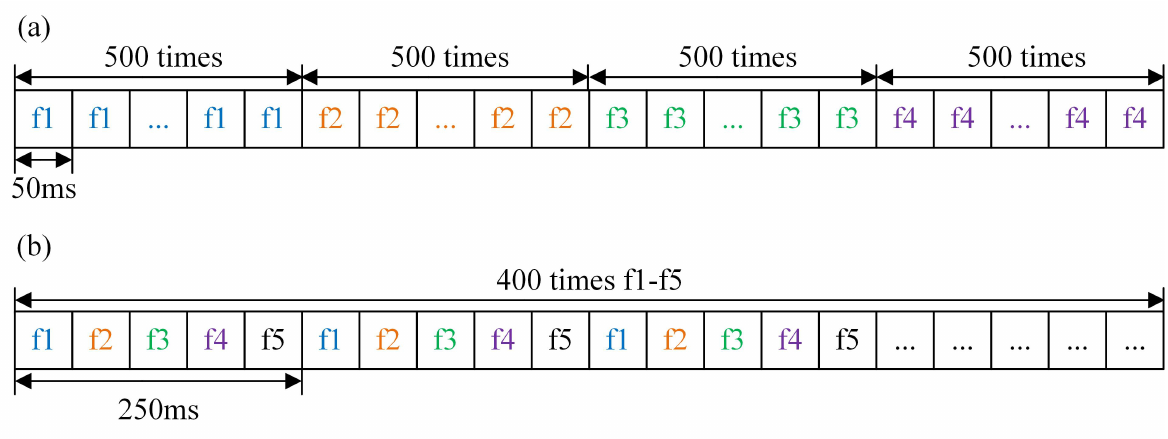
Figure 10. Transmitting sequence of drift detection of CAS-DIS. ( a ) The second experiment; ( b ) the third experiment and the last experiment.